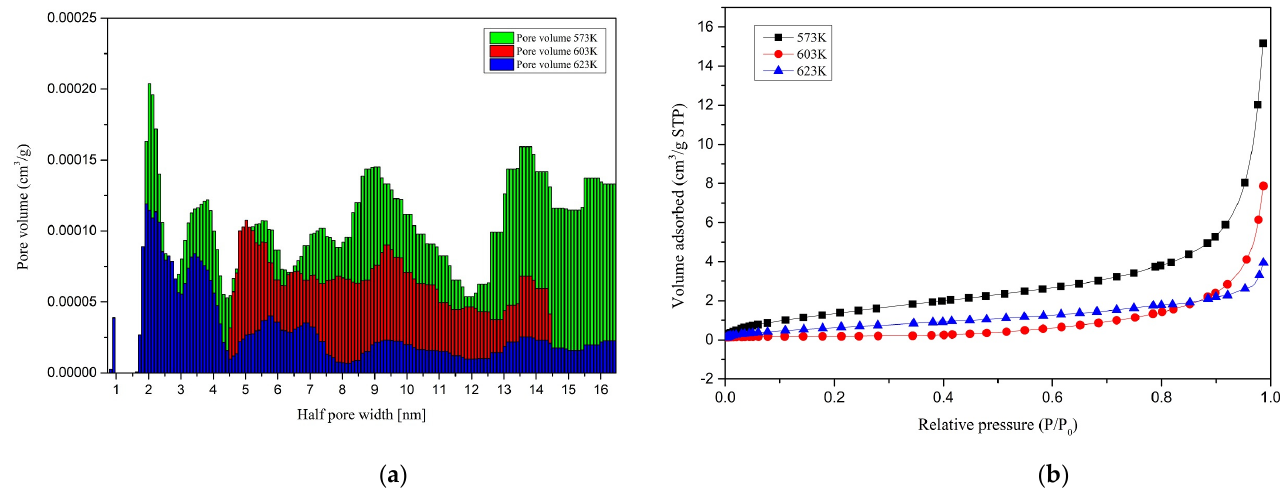
Figure 9. Adsorbed volume distribution ( a ) against micropore radius and ( b ) against relative pressure.